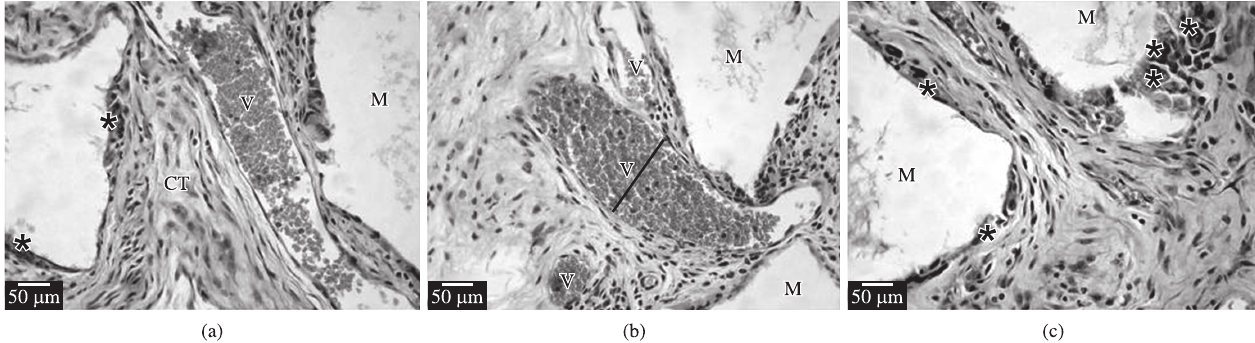
Figure 2. Histological sections, stained with HE, 14 days after grafting with HA (a) or ZnHA (b and c). Asterisks indicate Multinucleated Giant Cells. (M) indicates the grafted area. (V) indicates blood vessels. The bar identifies a congested vessel. (CT) indicates connective tissue.